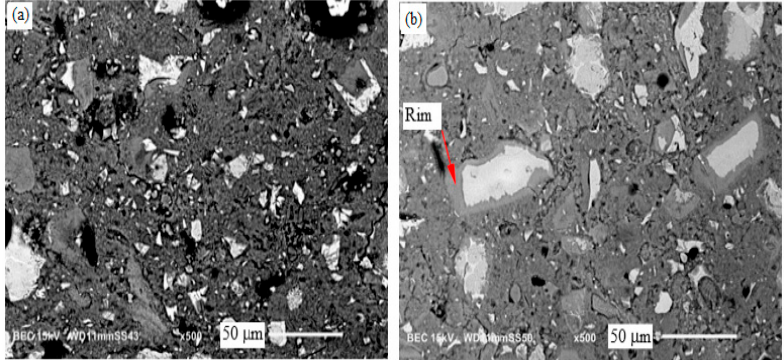
Figure 4. SEM images of cement (OPC) paste at the age of 28-days, ( a ) cured at room temperature, and ( b ) cured at 60 °C. Adapted with permission from [47], MDPI, 2016